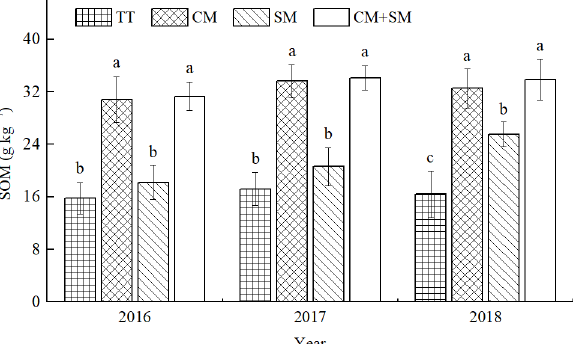
Figure 3. Mean soil organic matter (SOM) to the depth of 0.30 m for traditional tillage (TT), cattle manure mixing (CM), maize straw mulching (SM), and combined manure mixing and straw mulching (CM + SM) treatments from 2016 to 2018. The data were measured after maize harvesting. Means in the same year followed by the same letter are not statistically different according to least significant difference test ( p =